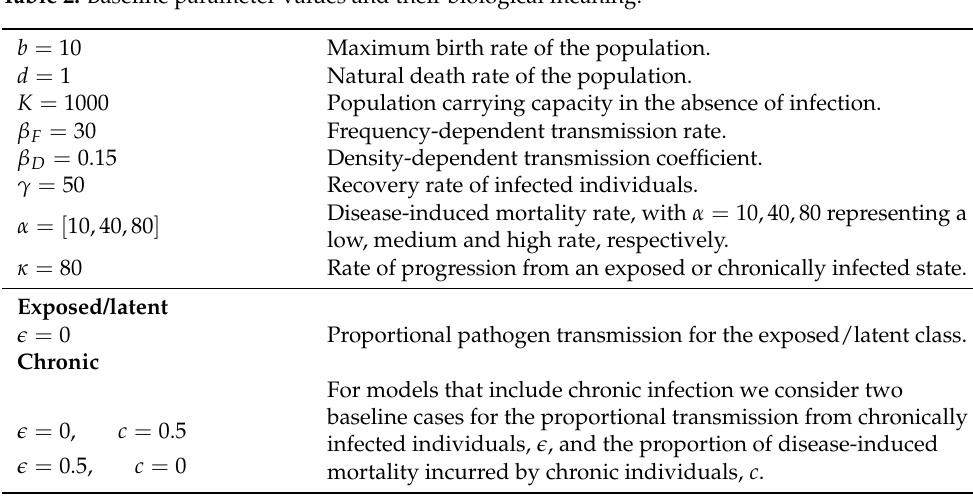
Table 2. Baseline parameter values and their biological